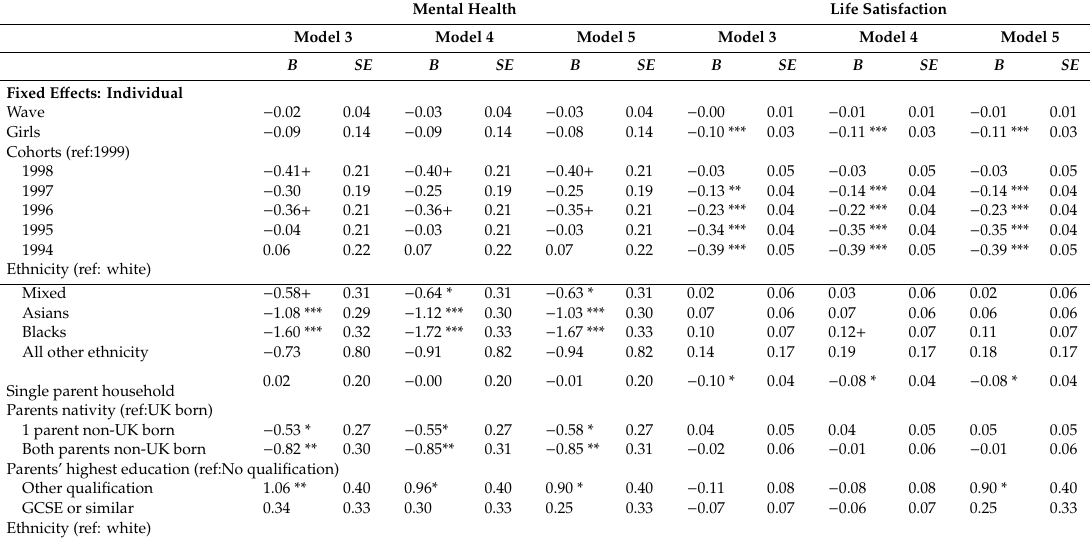
Table 4. Multilevel regression results of the association between deprivation and social capital on poor mental health and life